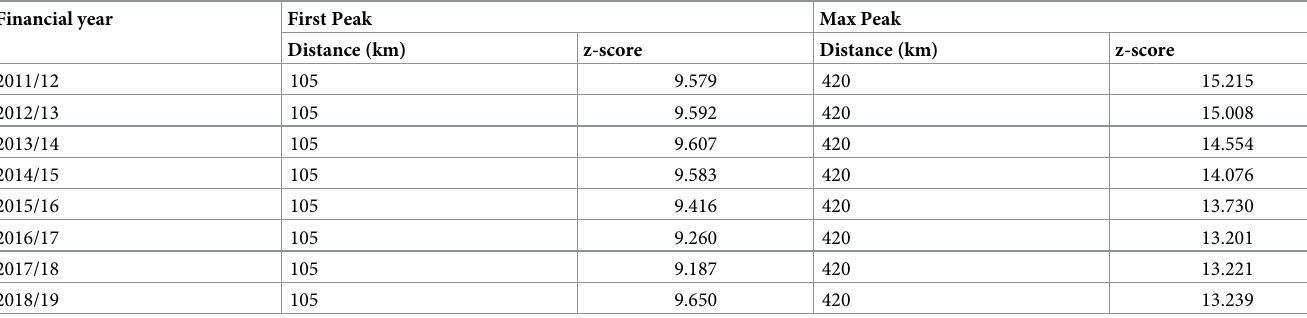
Table 4. Global Moran’s I summary by distance band.